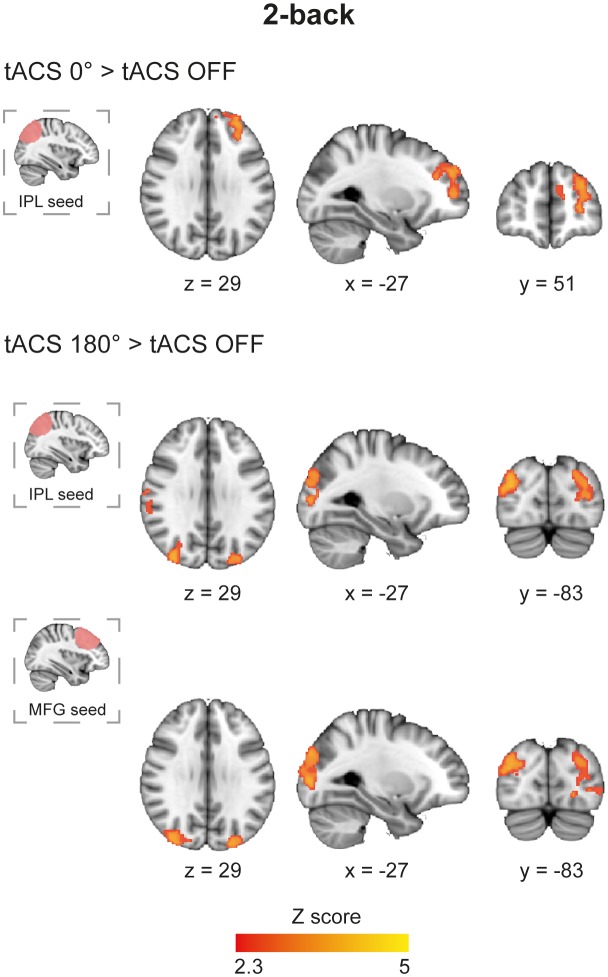
Functional connectivity in the 2-back task during synchronous and desynchronous tACS.Differential connectivity for synchronous versus desynchronous tACS during the 2-back task (n = 21). Synchronous tACS resulted in increased functional connectivity in comparison to tACS OFF between the parietal electrode region, IPL-electrode, and the dorsolateral prefrontal cortex during task performance. The desynchronous tACS condition increased functional connectivity between the parietal and frontal stimulated regions (IPL-electrode and MFG-electrode, respectively) and occipito-temporal regions. Images are in the Montreal Neurological Institute (MNI) space coordinates and in radiological space. All images have been thresholded with FSL clusterwise correction Z > 2.3, p<0.05.DOI:
http://dx.doi.org/10.7554/eLife.22001.01610.7554/eLife.22001.017Figure 5—source data 1.This folder contains the MRI contrast maps in Figure 5, both thresholded (that is, corrected for multiple comparison using cluster correction) and non-thresholded.The maps are in NIfTI format and can be opened with freely available data viewers such as FSLView or MRIcron.